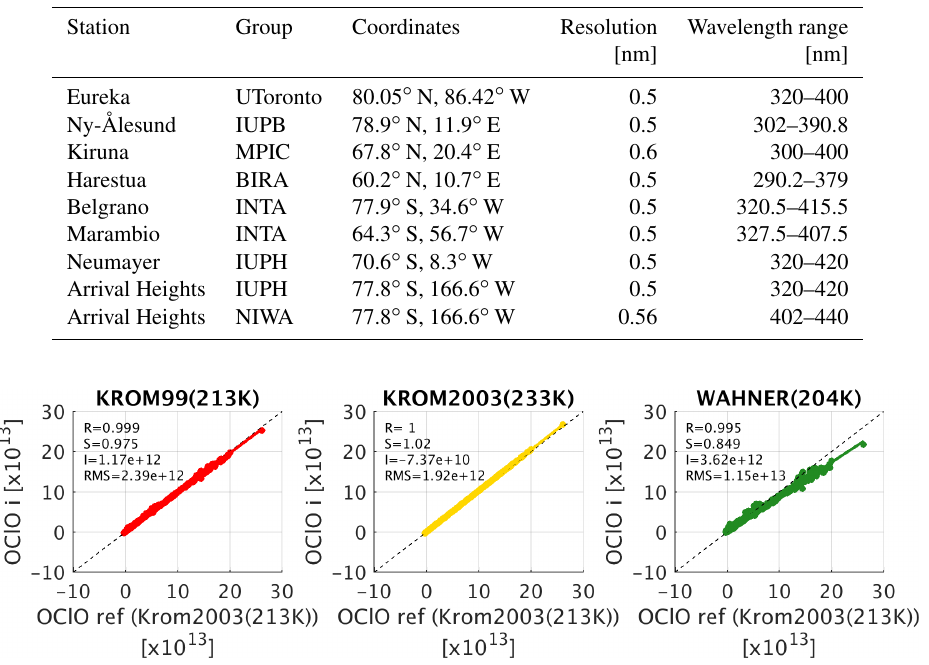
Table A1. Information on ground-based DOAS instruments.